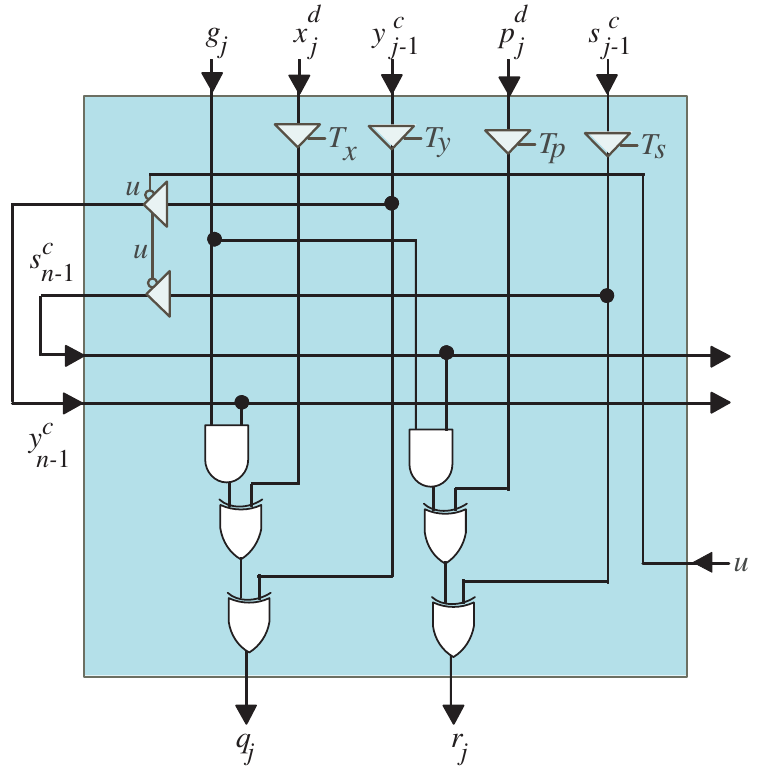
Figure 8. Logic details of the dark blue PE.